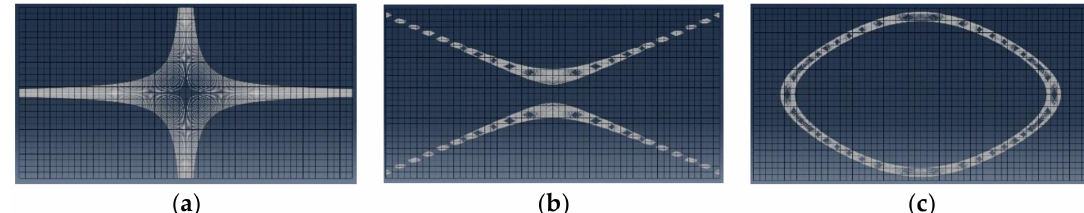
Figure 9. Nodal lines of the mode shapes of the Poisson plate, computed with the FE model. ( a ) Torsion mode shape, ( b ) saddle mode shape and ( c ) breathing mode